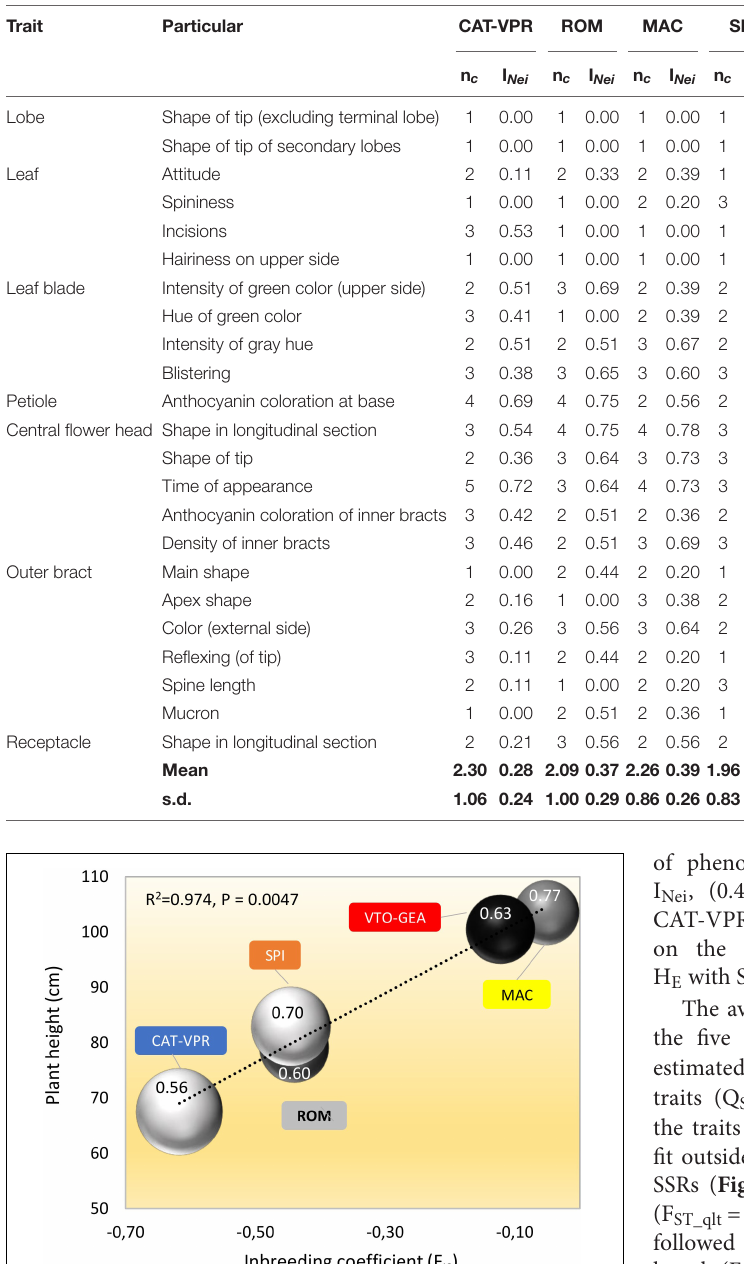
FIGURE 5 | Relationships between coefficient of inbreeding (F IS ), plant height (cm), gene diversity (H E ), linkage disequilibrium (LD), and average heritability (h 2 B ) for the five SSR groups of globe artichokes. Bubble size is proportional to the level of LD within the groups (as% of pair of loci with p < 0.05; Table 2 ); bubble shading (darkness) is proportional to the level of H E ( Table 2 ). The number within each bubble indicates the average h 2 B across the quantitative